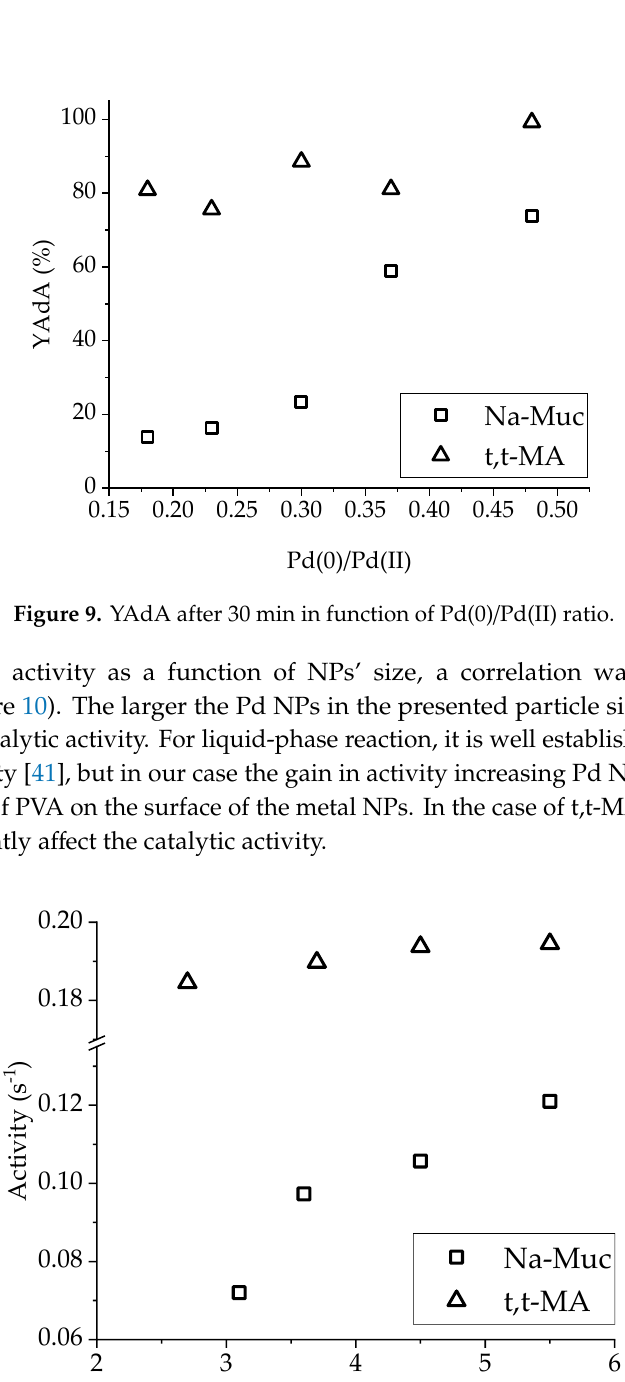
Figure 11. Influence of Pd/C ratio on YAdA (after 30 min of reaction) during t,t-MA hydrogenation with Pd/KB catalyst series. Recycling tests on the Pd/KB_1.2 sample were performed to study the stability and reusability of the catalyst which gave the best results in term of conversion and AdA yield for both the reactions. Five runs were performed recovering the catalyst and without making any treatment before the